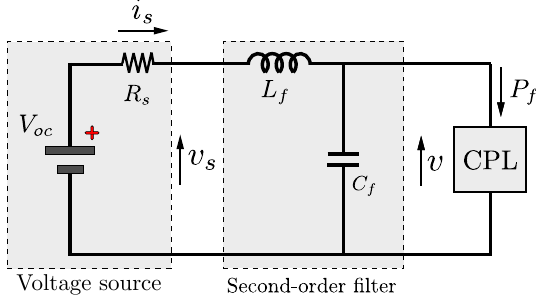
Figure 5. Scheme of the equivalent electrical circuit of the second-order input filter with